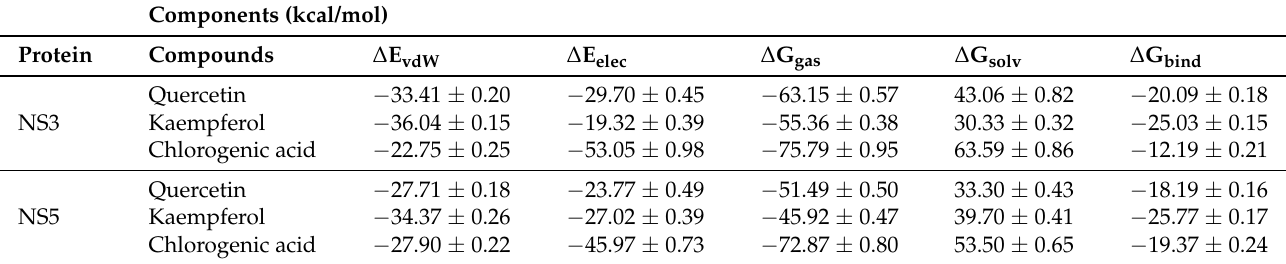
Table 2. Thermodynamic binding free energy (average) for PLE compounds from MM/GBSA with NS3 and NS5